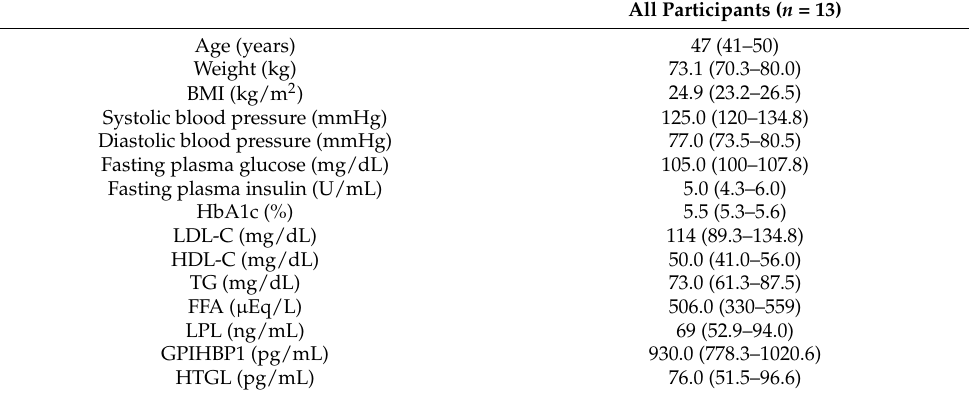
Table 1. Baseline characteristics of the 13 subjects without diabetes mellitus or